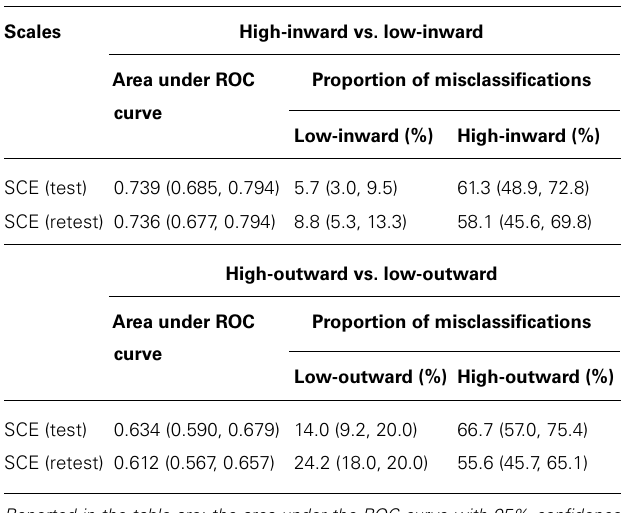
Reported in the table are: the area under the ROC curve with 95% confidence intervals, and the proportions of misclassified participants, with 95% confidence intervals.